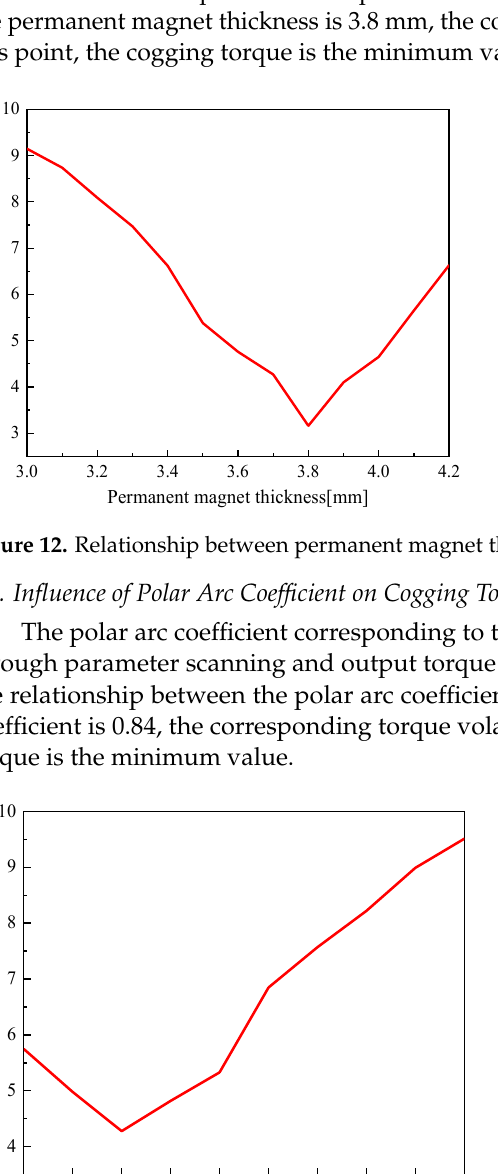
Figure 13. The relationship between the arc coefficient and the cogging torque.